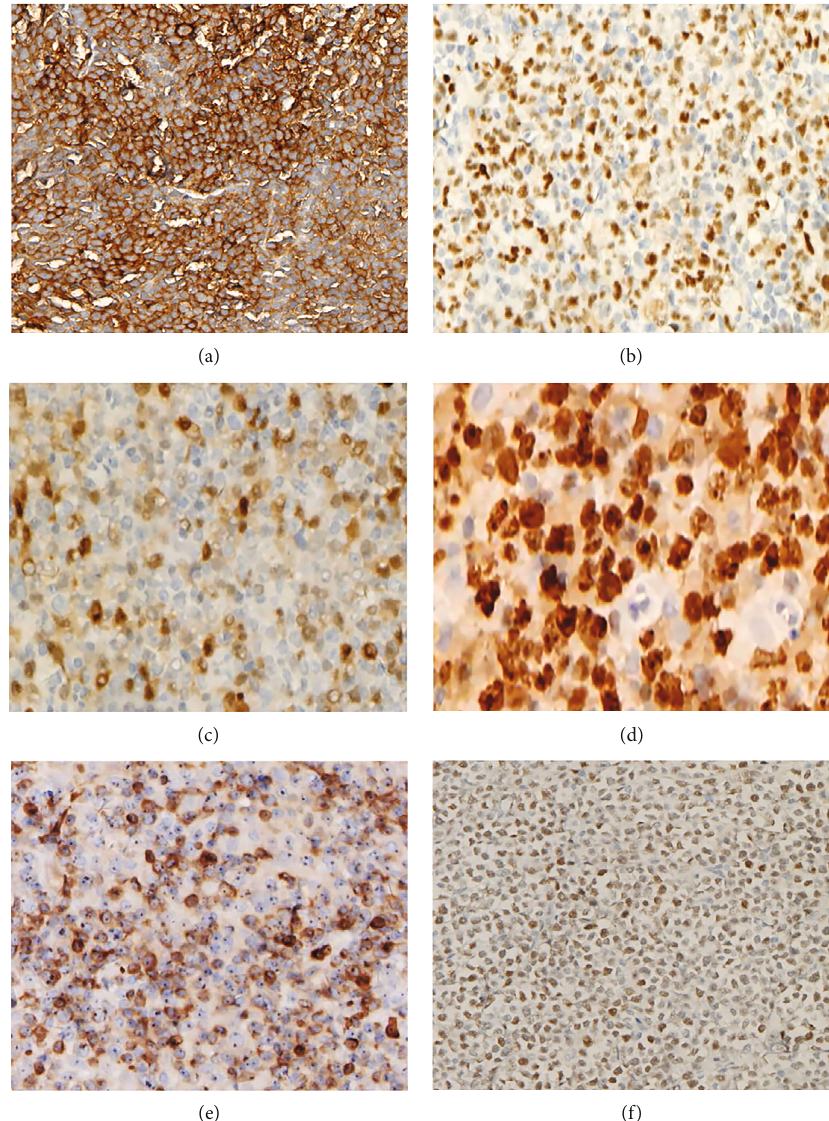
Figure 2: Immunohistochemical results (EnVision method, original magni fi cation 200x) of DLBCL. (a – f) CD10, Bcl-6, Mum1, Ki67, Bcl-2, and MYC expression on